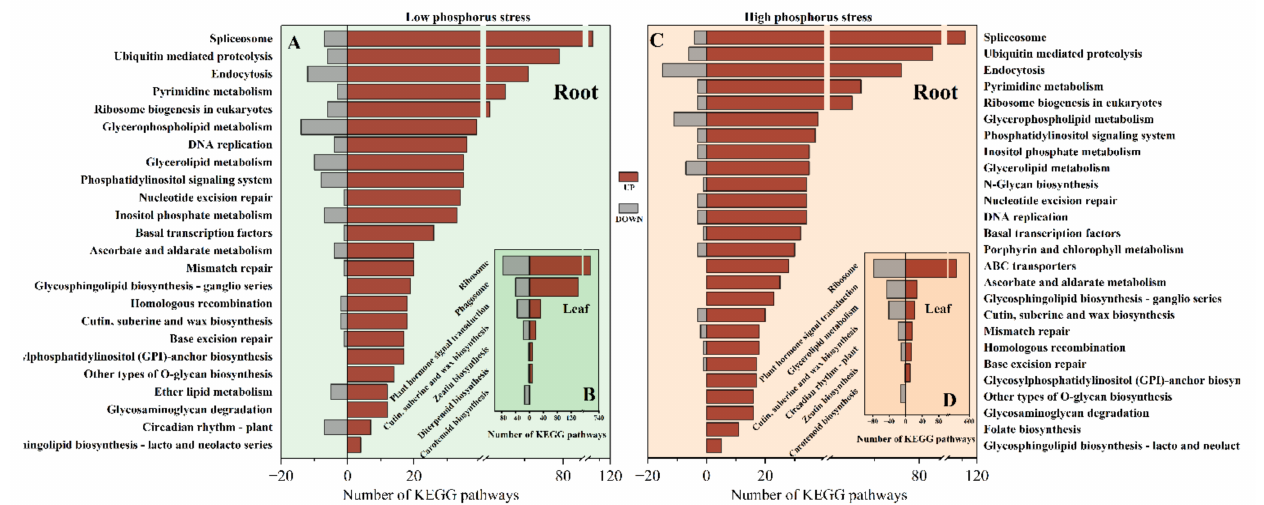
Figure 6. Significantly regulated Kyoto Encyclopedia of Genes and Genomes (KEGG) pathways among different groups in Myriophyllum aquaticum , leaf and root from low phosphorus concentration treatment ( A , B ); leaf and root from high phosphorus concentration treatment ( C , D